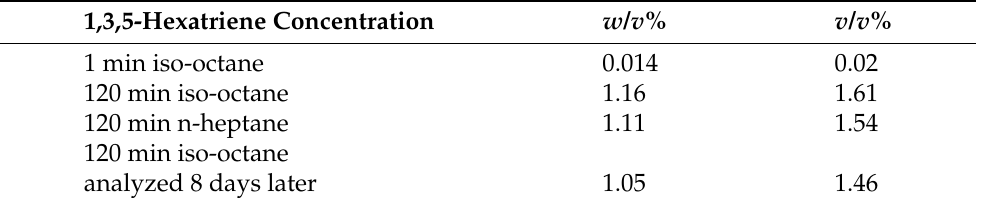
Table 2. Analysis results of the Pen-Ray lamp experiments: hexatriene concentrations in the samples.